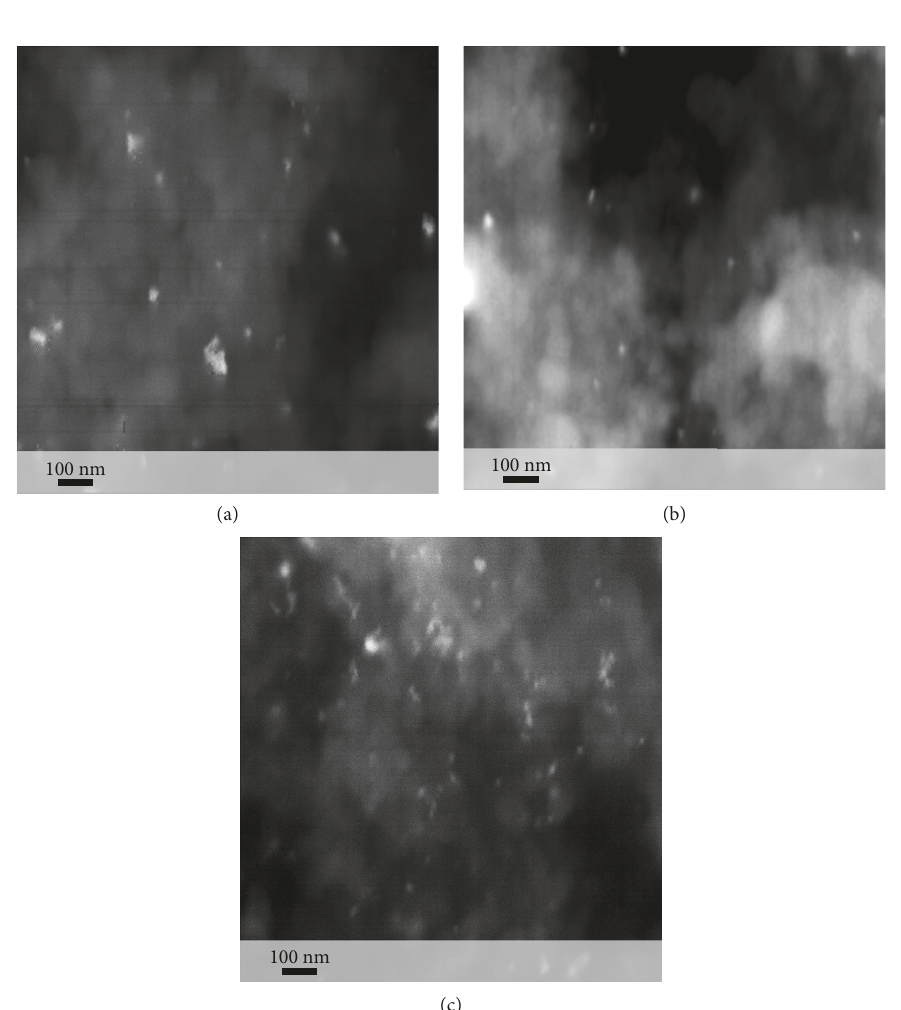
Figure 3: SEM images (magnification 100 000) of bimetallic (a) PdIr-0.02/C, (b) PdIr-0.08/C, and (c) PdIr-0.2/C